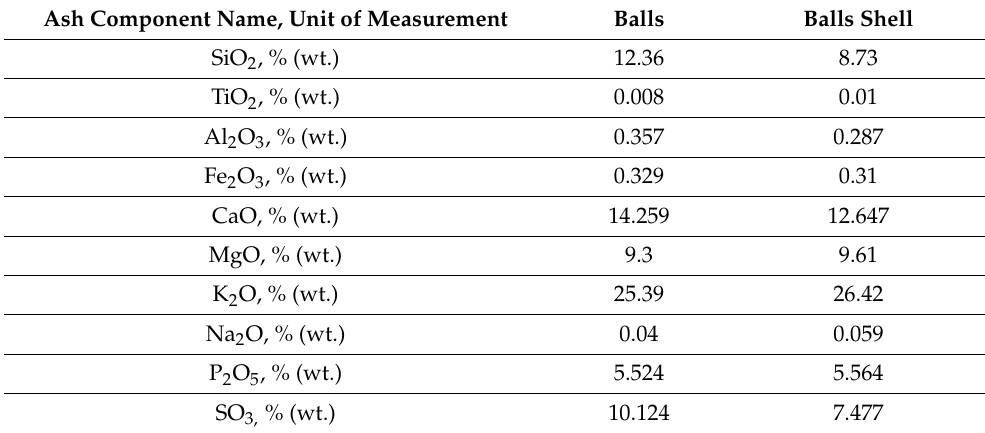
Table 2. The chemical composition (on a dry basis) of the ash of the balls and the shell of the balls extracted from the fluidized bed of sand when burning pellets from sunflower husks in it. Ash Component Name, Unit of Measurement Balls Balls Shell SiO 2 , % (wt.)